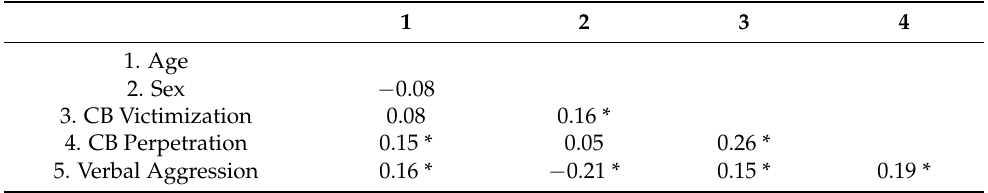
Table 2. Pearson correlations among